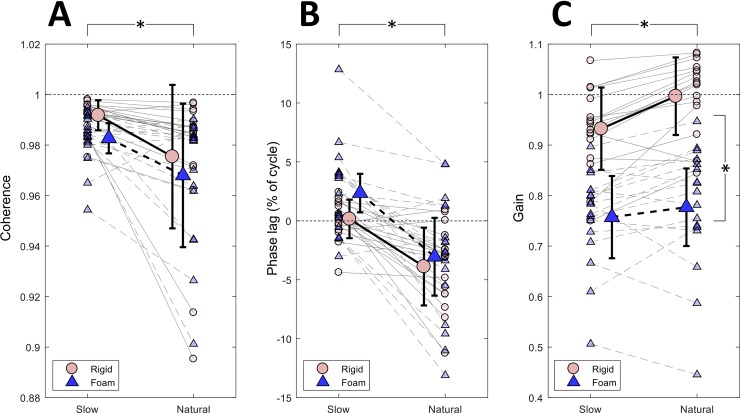
Results of the coherence analysis.Group results of the CoPAP-target coherence (A), phase lag (B) and gain (C) for the slow and natural voluntary sway on stable (rigid) and unstable (foam) ground. Pink circles connected with continuous lines and blue triangles connected with dashed lines represent the condition of sway on rigid ground and foam, respectively. Small and large symbols (circles and triangles) represent data of each individual and group means, respectively. Vertical lines designate one standard deviation and asterisks express the presence of significant main effect (p<0.05).